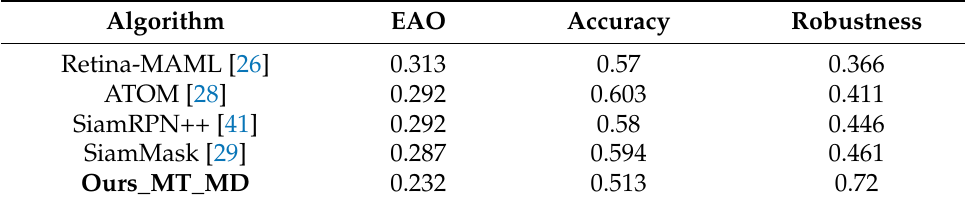
Table 4. Comparison on